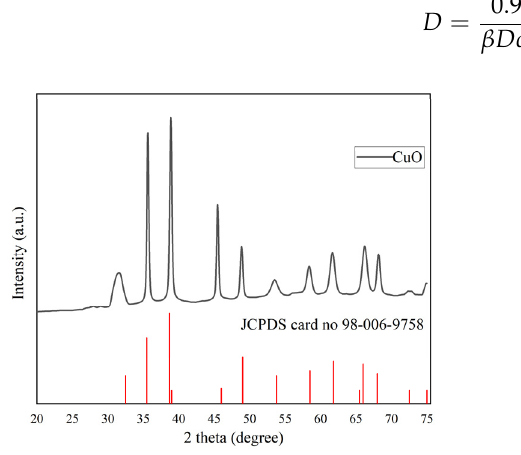
Figure 6. X-ray Diffraction of CuO NPs.